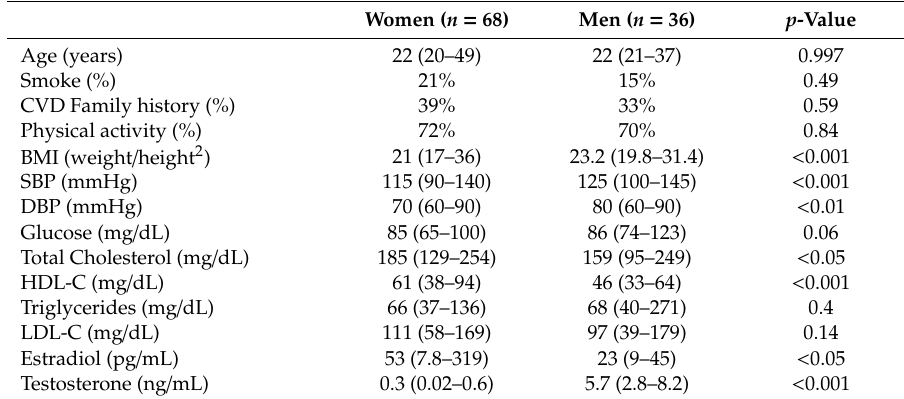
Table 1. General characteristics of women and